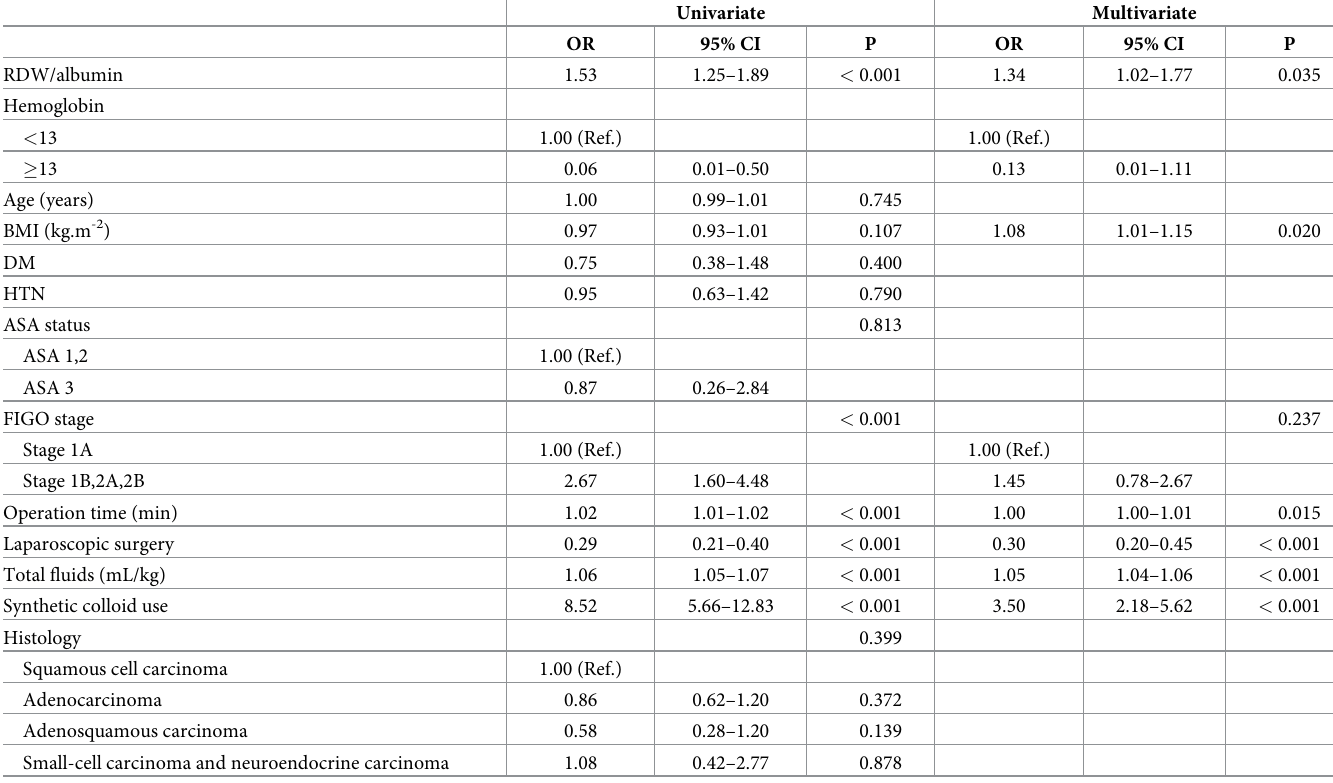
Table 2. Univariate and multivariate logistic regression analysis of intraoperative transfusion.